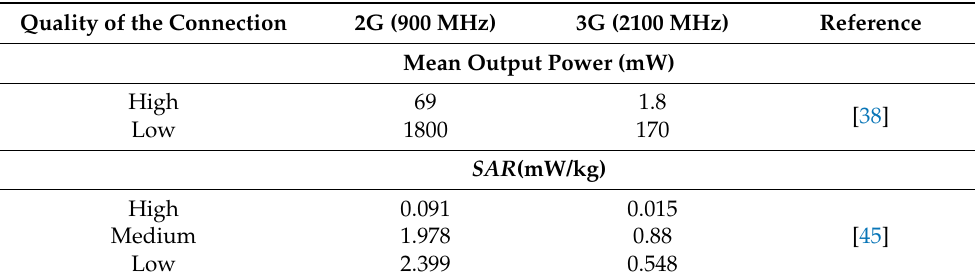
Table 8. Mean output power (mW) and SAR values (mW/kg) for 2G and 3G HHDs for data uploading depending on the quality of the connection.